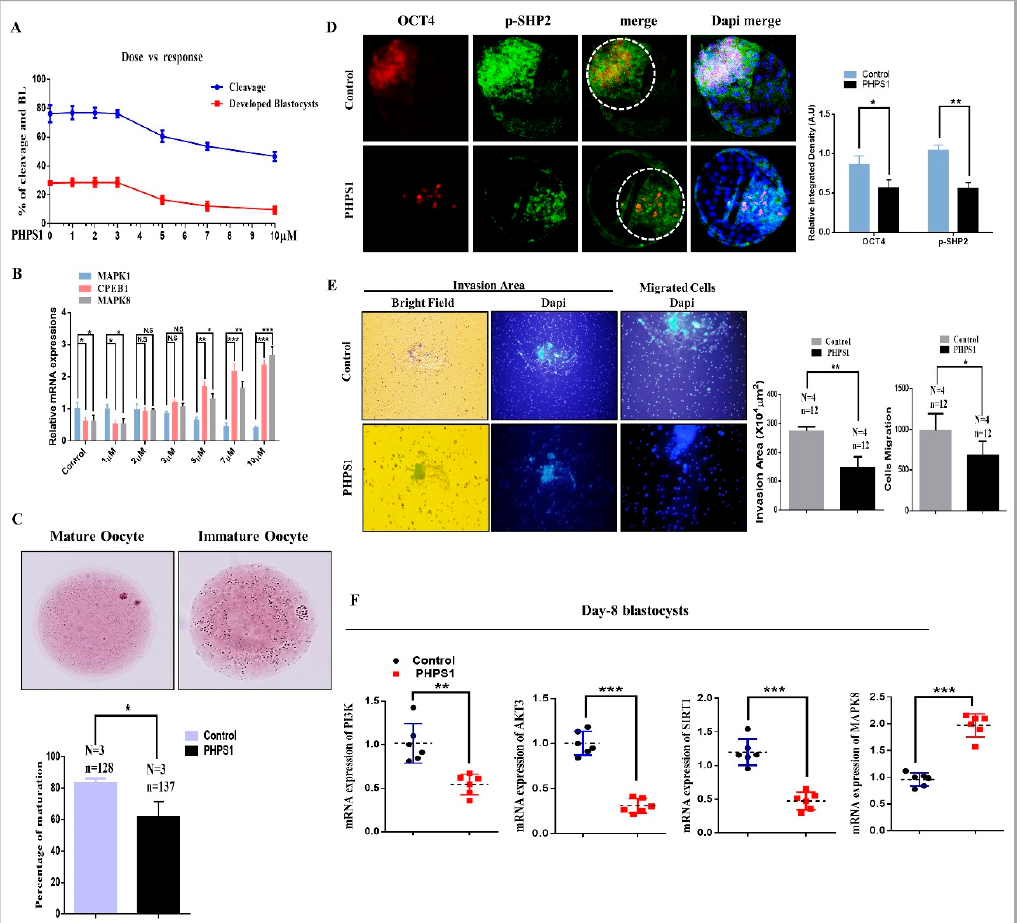
Figure 2. The effects of SHP2 inhibition was analyzed during oocytes maturation and blastocysts development. ( A ) Dose dependent response of PHPS1 (SHP2 inhibitor) toward embryo cleavage and blastocysts development. ( B ) Dose dependent effect of PHPS1 on oocyte maturation pathways.